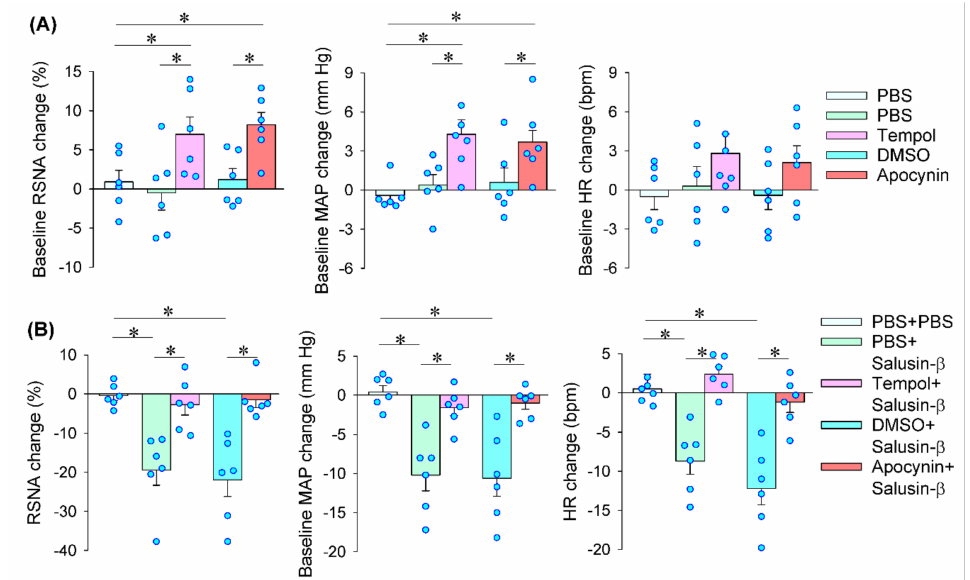
Figure 5. Effects of tempol and apocynin on the salusin- β -induced RSNA, MAP and HR changes. ( A ) Baseline RSNA, MAP and HR changes induced by tempol (20 nmol) and apocynin (3 nmol) in the iDMV. ( B ) Effects of pretreatment with tempol or apocynin in the iDMV on the salusin- β -induced RSNA, MAP and HR changes. The pretreatment was carried out 10 min before microinjection of salusin- β (100 pmol) in the the iDMV. * p <